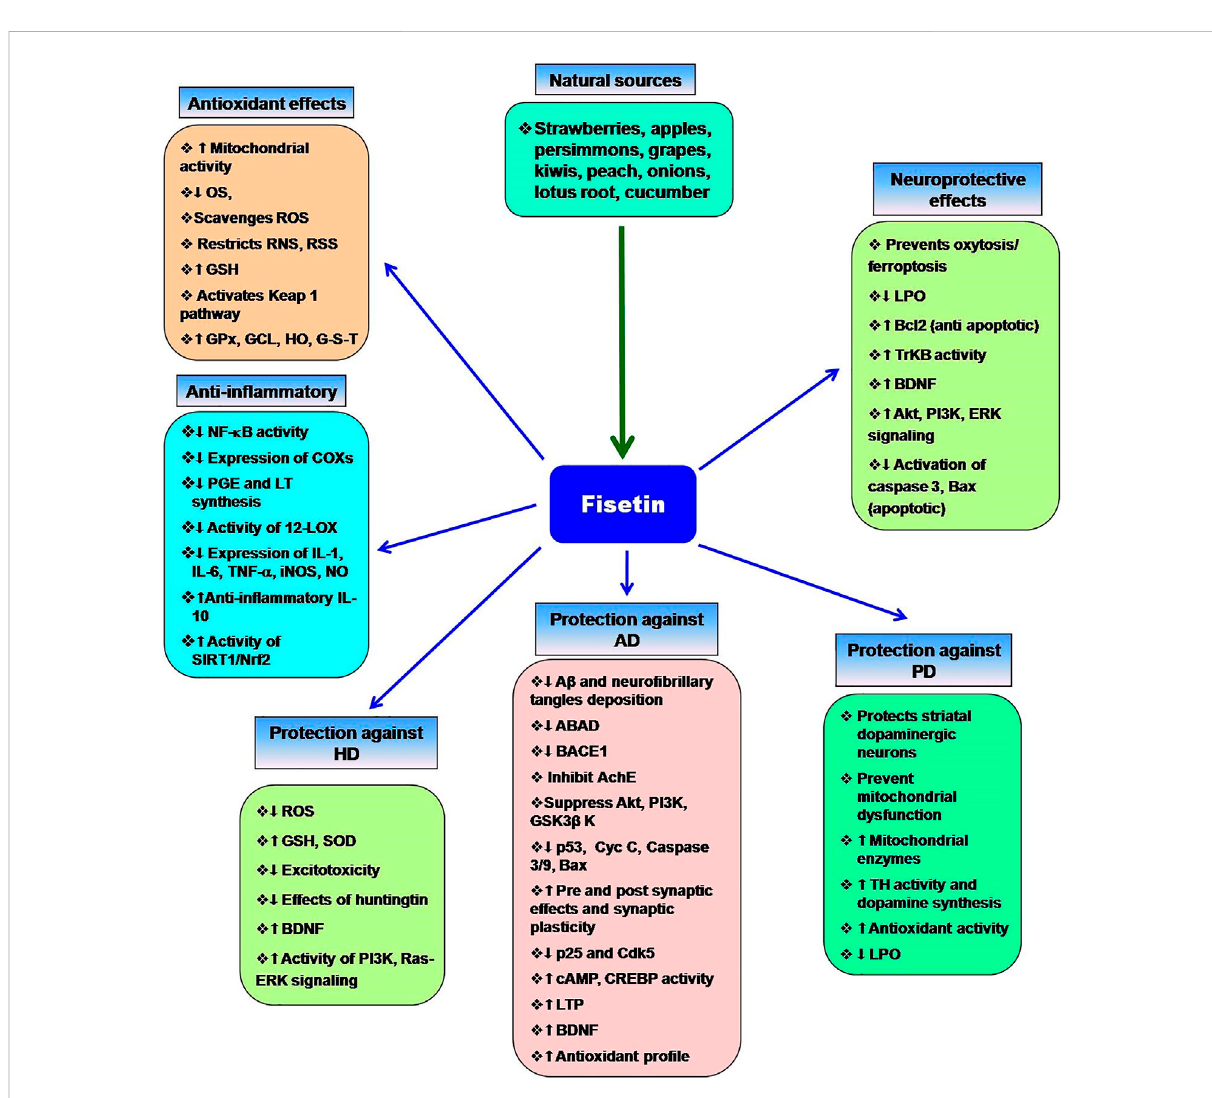
FIGURE 2 Multifaceted activities of fi setin and its neuroprotective functions. The role of OS the neurodegenerative diseases and the protective effects of fi